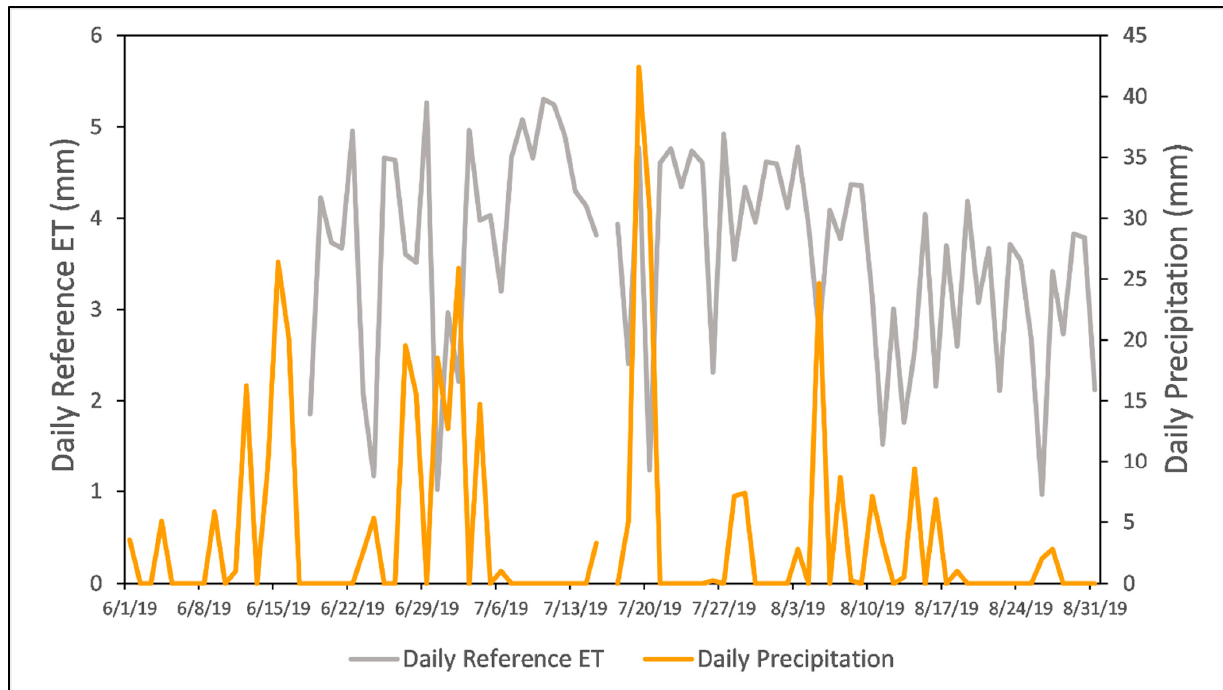
Figure 1. Map of 2019 study site. Flight domain is centered around an EC tower. The meteorological station was located 3.9 km southeast of the site. Aerial imagery provided by Google Earth.